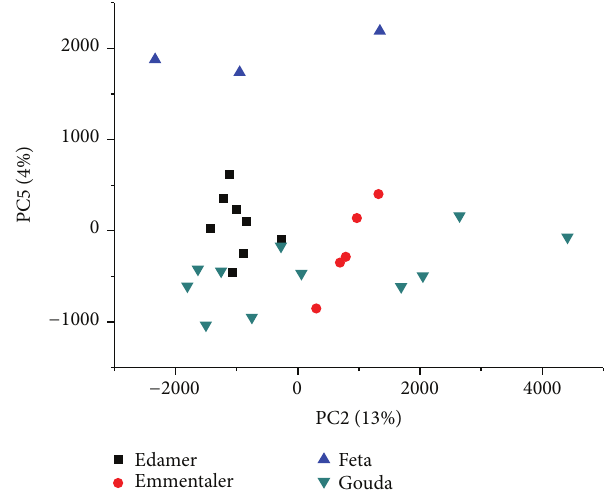
Figure 5: PCA of cheese types in the aliphatic region (3.0– 0.25